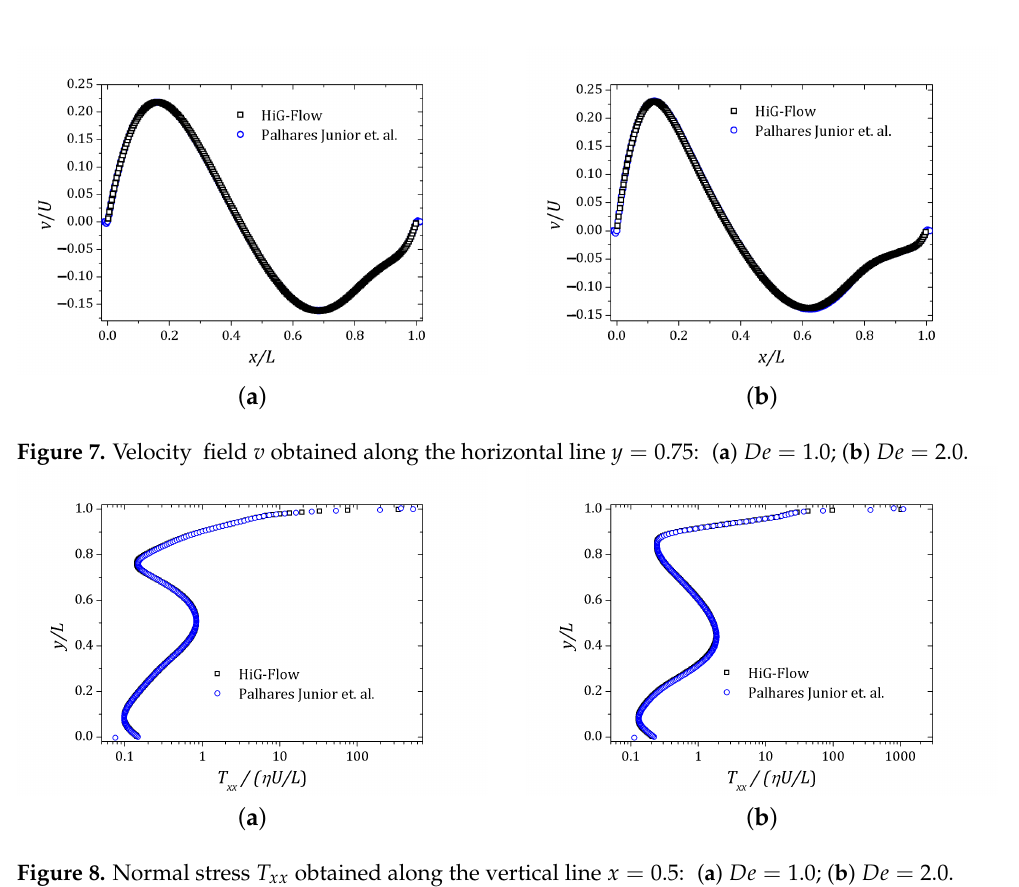
Figure 8. Normal stress T xx obtained along the vertical line x = 0.5: ( a ) De = 1.0; ( b ) De =